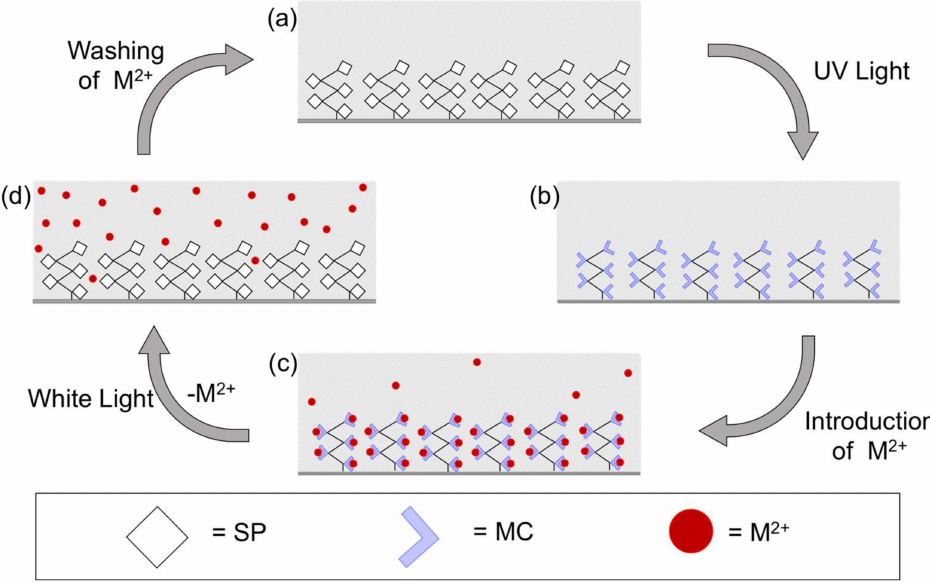
Figure 6. Schematic representation of the metal ion binding, sensing, and release cycle in the SP polymeric brushes coated micro-capillary. ( a ) polySP coated micro-capillary before irradiation; ( b ) formation of polyMC upon UV irradiation; ( c ) binding of M 2+ to polyMC coating; ( d ) photo-controlled release of M 2+ upon white light irradiation and regeneration of polySP